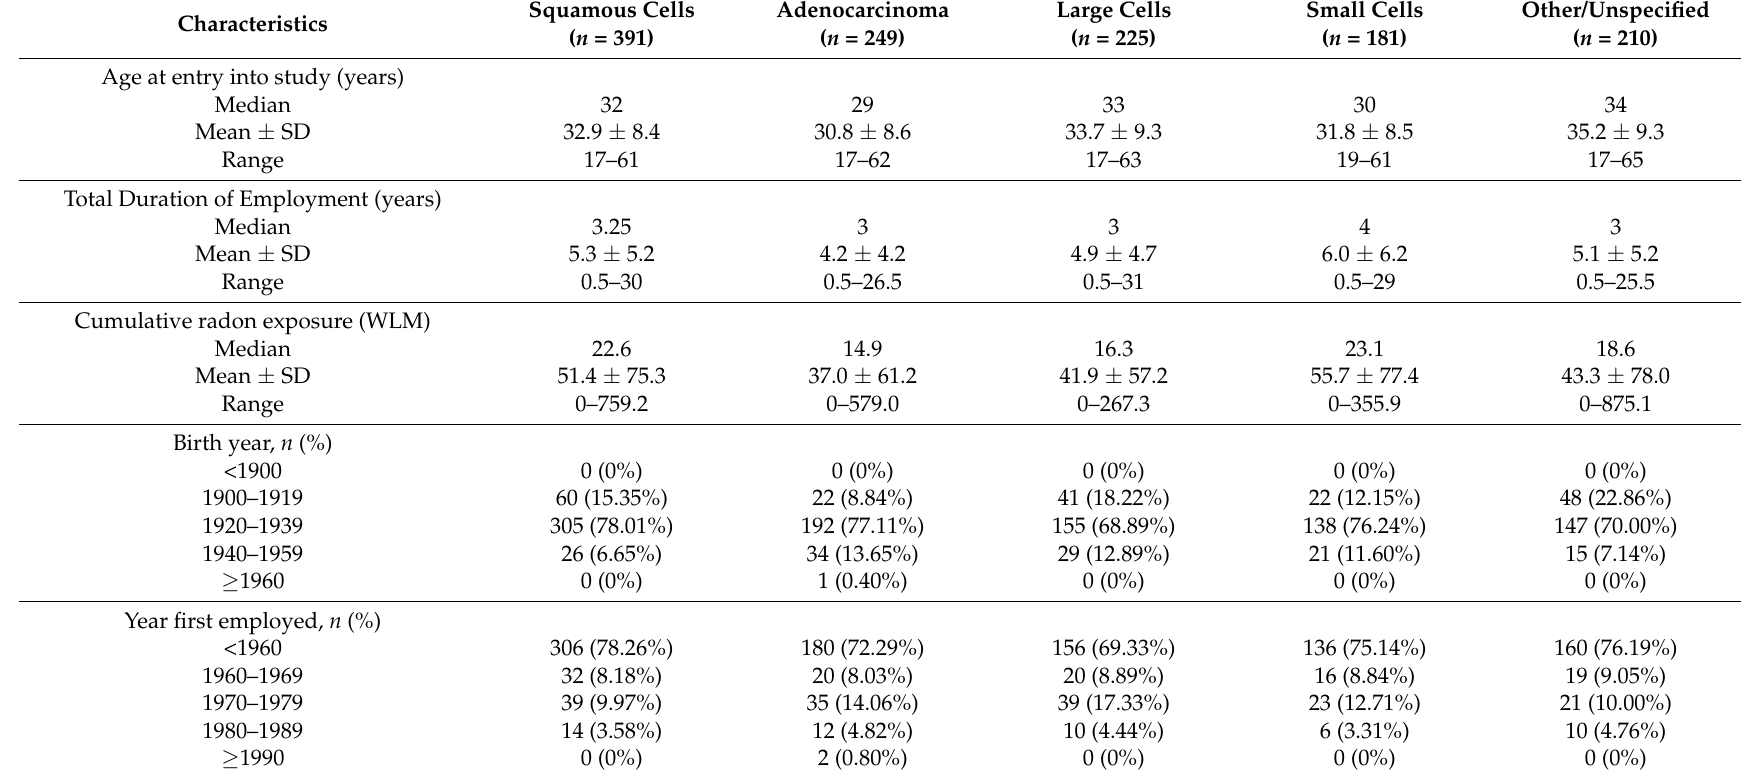
Table 3. Characteristics of lung cancer diagnosis by histology subtypes, Ontario uranium